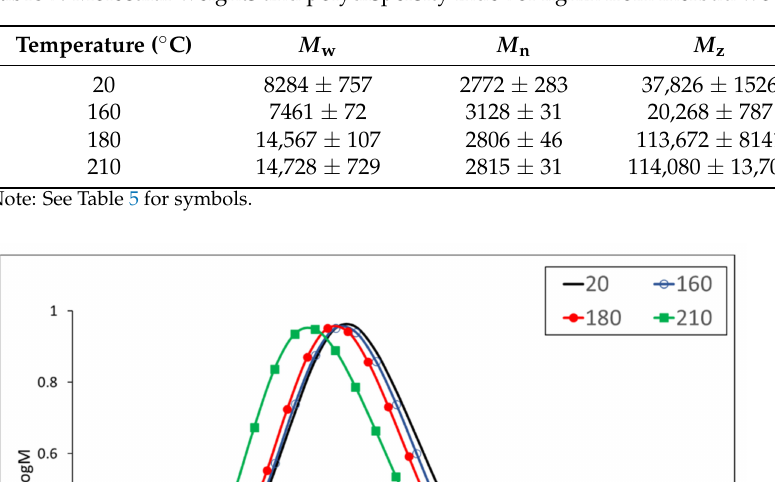
Table 7. Molecular weights and polydispersity index of lignin from merbau wood (mean ± SD).